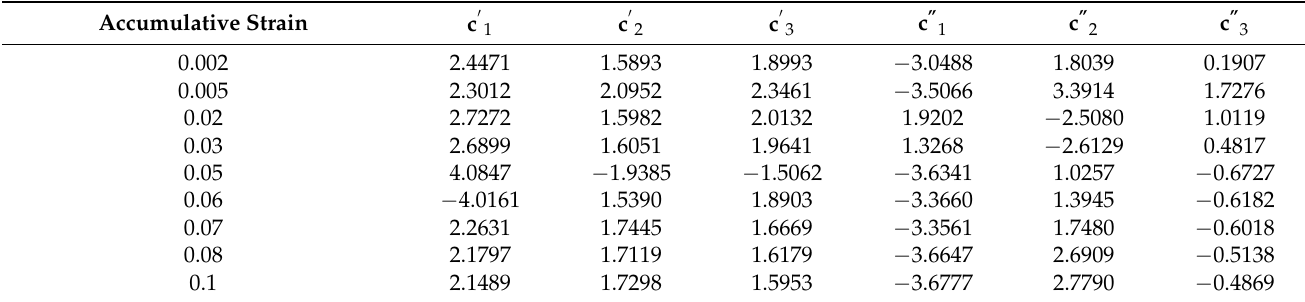
Table A1. Anisotropic parameters of ZK60 magnesium